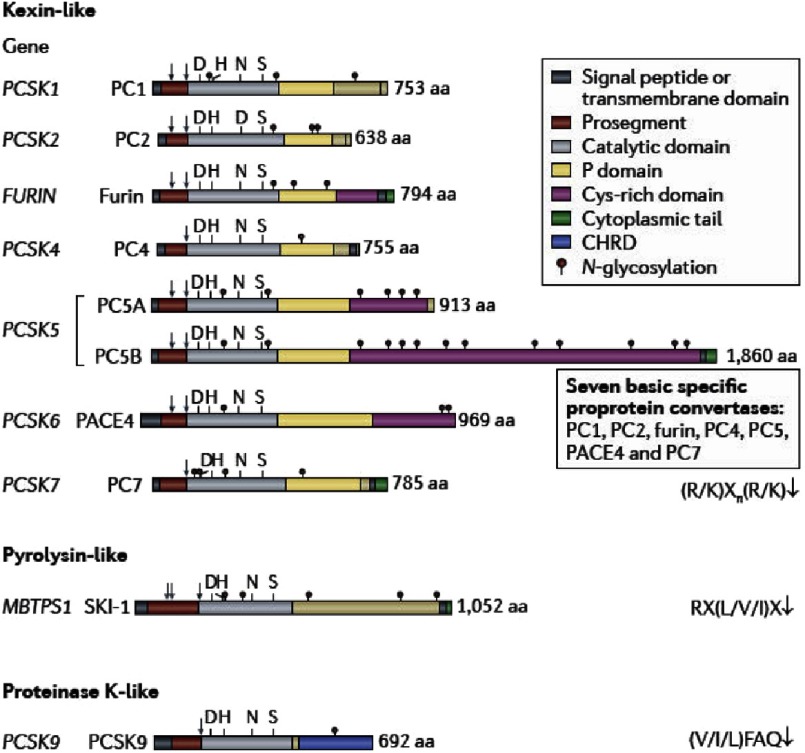
Schematic representation of the primary structures of the human proprotein convertases.The kexin-like basic amino acid (aa)-specific proprotein convertases, pyrolysin-like subtilisin kexin isozyme 1 (SKI-1; encoded by the MBTPS1 gene) and proteinase K-like proprotein convertase subtilisin kexin 9 (PCSK9) are individually grouped to emphasize their distinct subclasses. The various domains and N-glycosylation positions are emphasized, along with the primary (depicted using light grey arrows, and a light grey double arrow for SKI-1) as well as the secondary autocatalytic processing sites (depicted using dark grey arrows). The presence of a signal peptide, a prosegment and catalytic domain is common to all convertases that exhibit the typical catalytic triad residues Asp, His and Ser, as well as the Asn residue comprising the oxyanion hole (Asp for PC2). The carboxy-terminal domain of each convertase contains unique sequences regulating their cellular localization and trafficking. Thus, PCSK9 exhibits a Cys-His-rich domain (CHRD) that is required for the trafficking of the PCSK9–LDLR (low-density lipoprotein receptor) complex to endosomes and lysosomes. (modified from11).